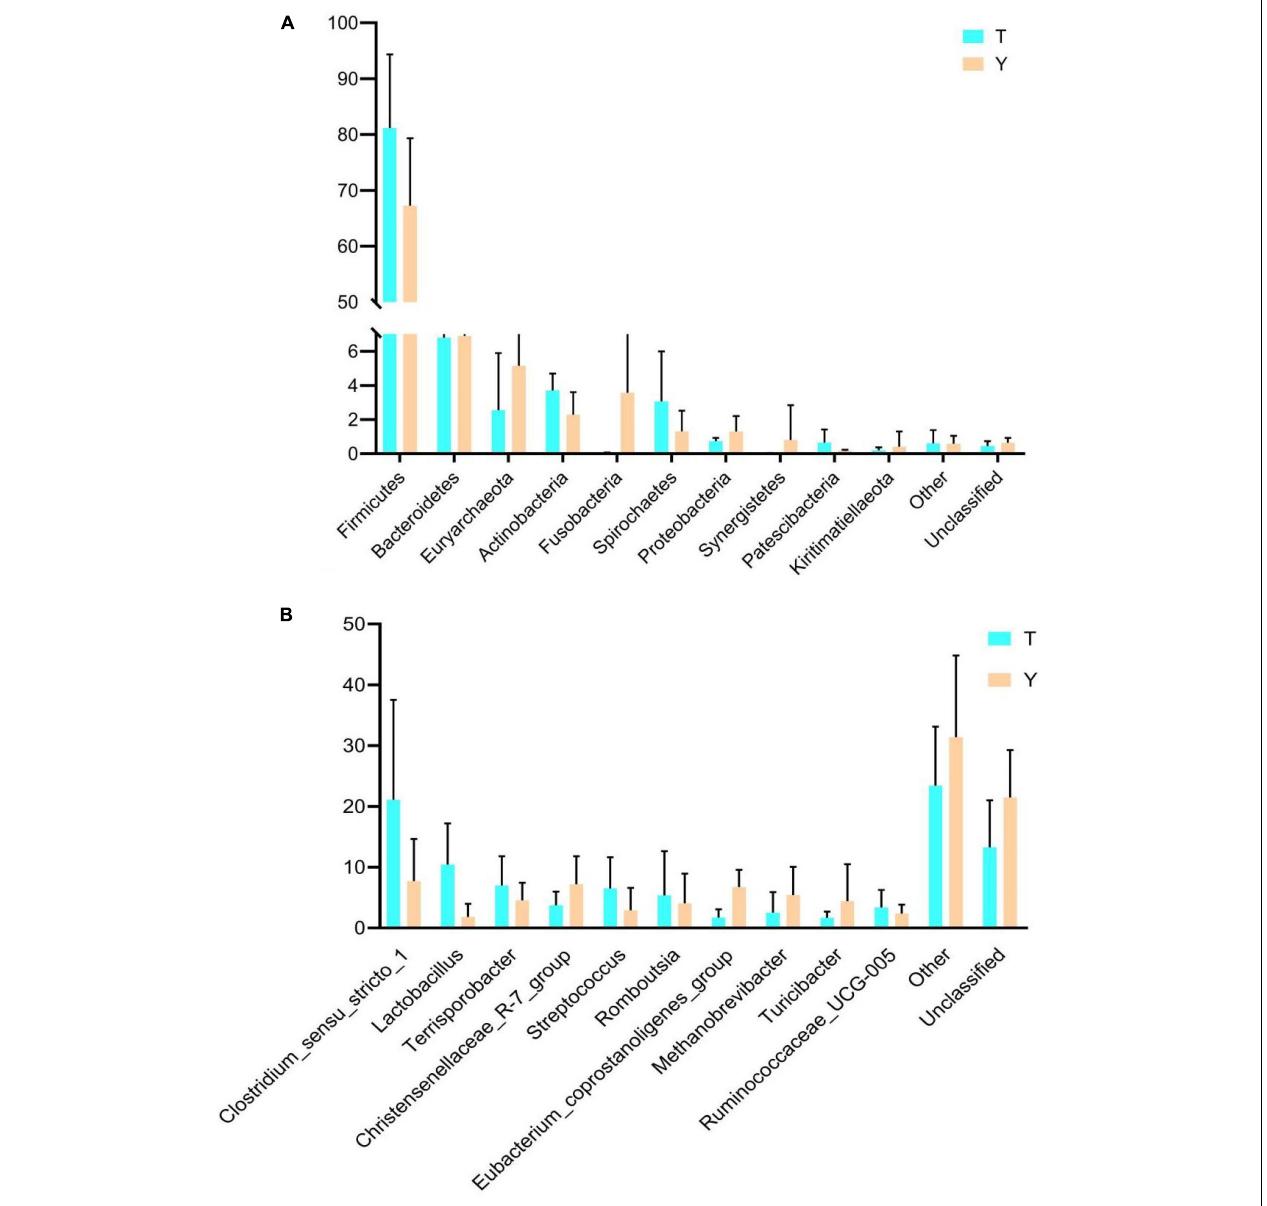
FIGURE 5 | Comparison of community differences in intestinal microbial composition between Tibetan pigs and Yorkshire pigs at the phylum (A) and genus (B) levels. All data represent average values.